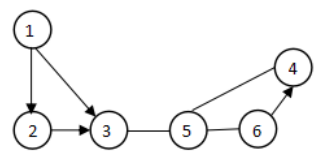
Figure 1. Disassembly Hybrid Graph.